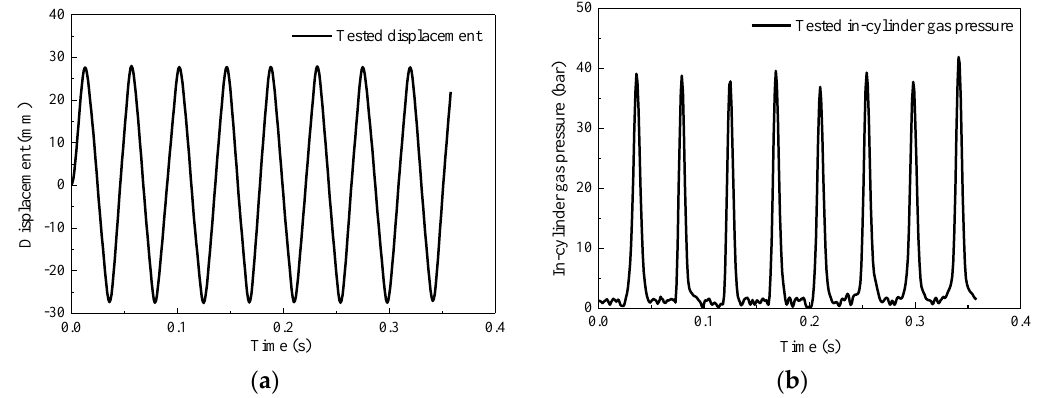
Figure 10. ( a ) The tested piston position results; ( b ) the tested in-cylinder gas pressure results.